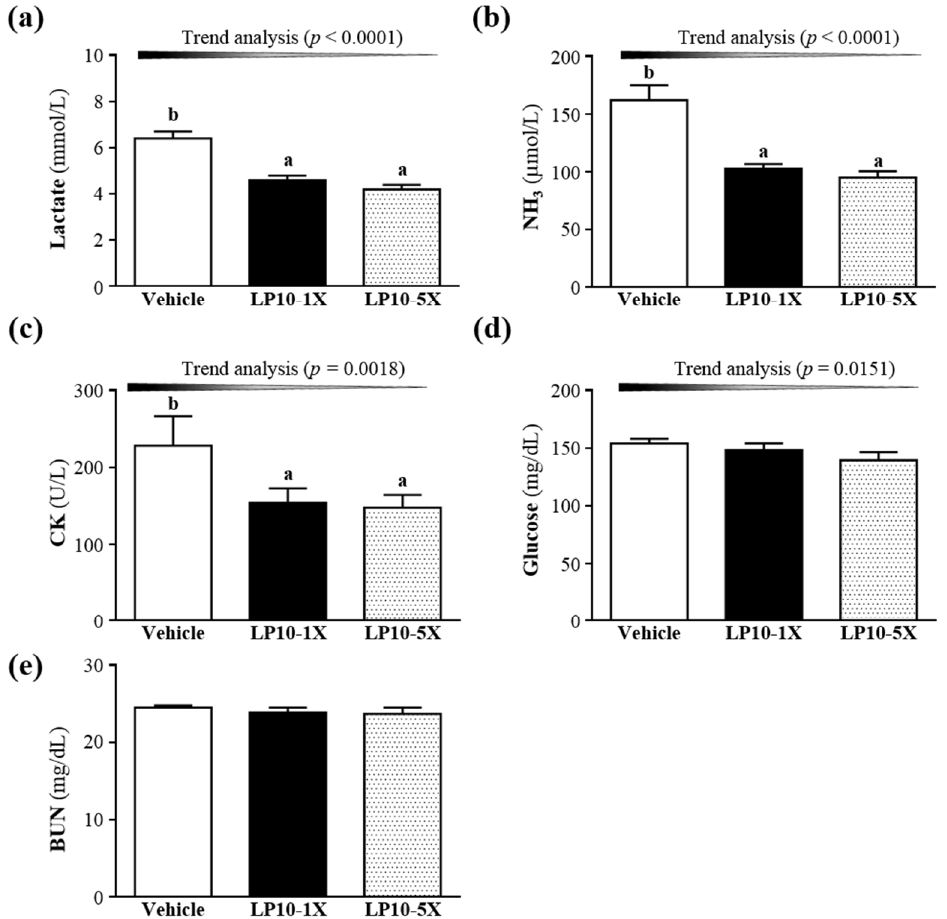
Figure 3. Effect of LP10 supplementation on serum levels of lactate ( A ); ammonia ( B ); creatine kinase (CK) ( C ); glucose ( D ); and blood urea nitrogen (BUN) ( E ) after acute exercise challenge. Data are mean ± SEM, n = 8 mice/group, by one ‐ way ANOVA. Different letters (a, b) indicate a significant difference at p < 0.05.